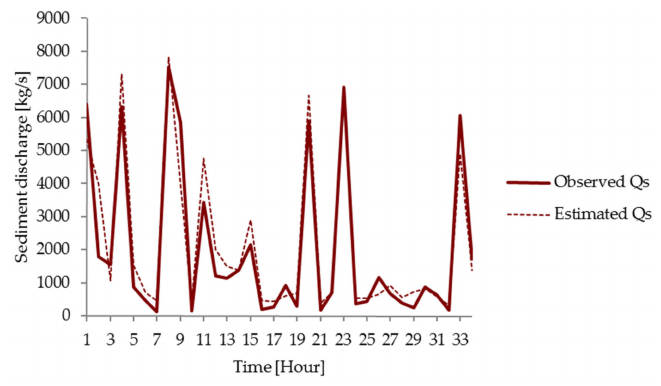
Figure 11. Observed and estimated sediment discharge at testing stage using MLP.